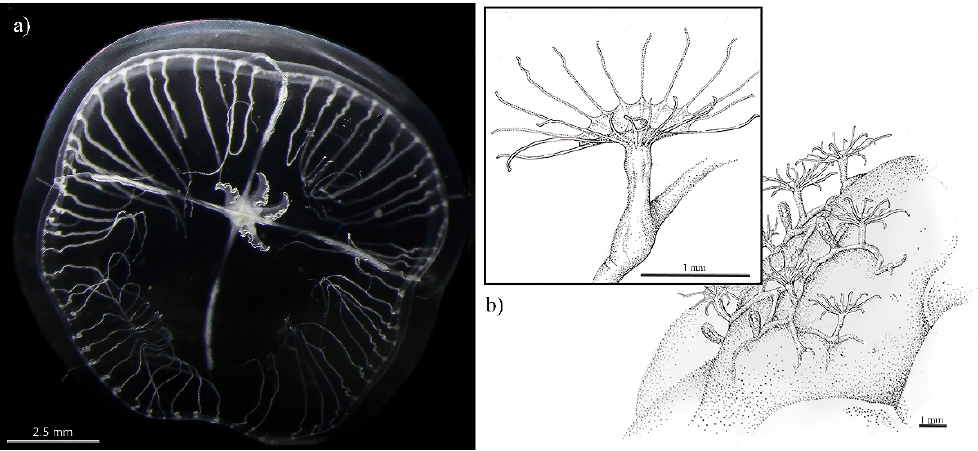
Figure 6. Non-indigenous hydromedusae Blackfordia virginica medusae ( a ), with polyp colony and detailed scyphistoma morphology (inlet). Image credit a: C. Jaspers, ( b ): N. Bezio.